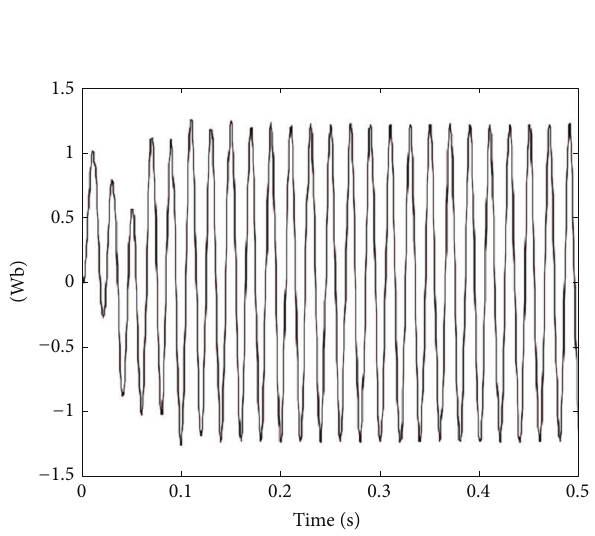
Figure 1: Real flux 𝜑 𝑎 .